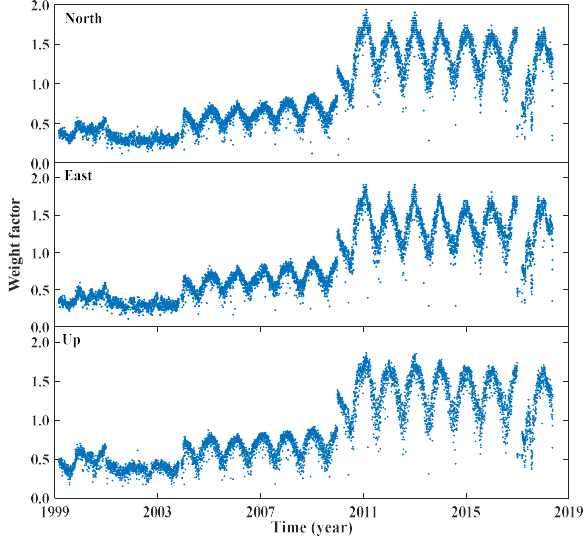
Remote Sens. 2020 , 12 , x FOR PEER REVIEW Figure 8. Weight factor of position time series for BJFS station. Figure 8. Weight factor of position time series for BJFS station.